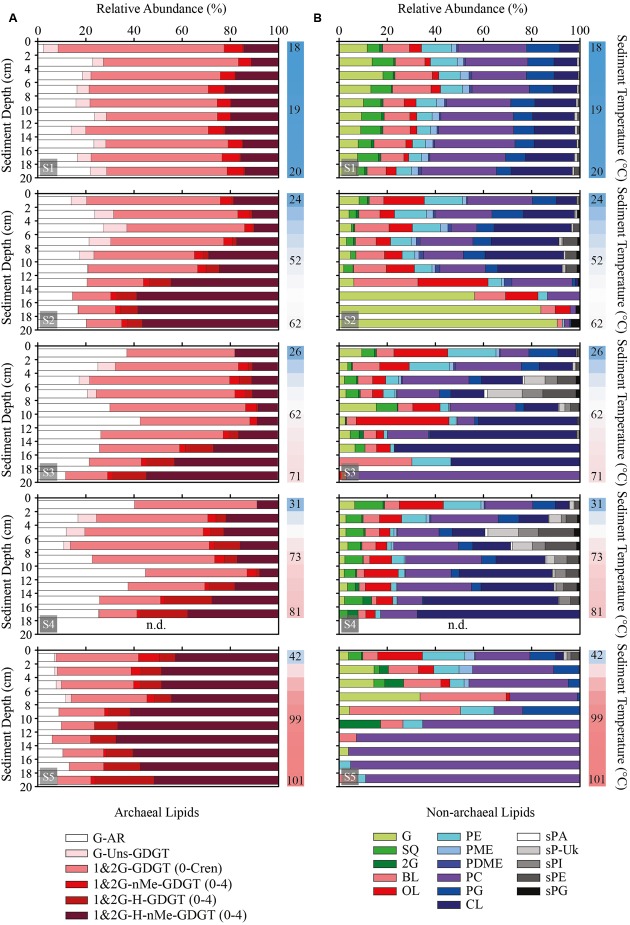
Sediment profiles displaying the abundance of polar lipid classes relative to total archaeal (A) and total non-archaeal (B) lipids. Note that this figure should be interpreted together with the relative abundance of archaeal and bacterial polar lipids shown in Figure 2. Samples were analyzed in 2 cm horizons from surface until 20 cm of sediment depth. Adjacent vertical bars indicate the thermal gradient of each station with upper, mid and bottom sediments temperatures in °C. n.d., no data. Abbreviations: monoglycosidic archaeol (AR); monoglycosidic unsaturated (Uns) acyclic glycerol-dibiphytanyl-glycerol-tetraethers (GDGT); mono- and diglycosidic GDGT with 0 to 5 rings (0-Cren); mono- and di-glycosidic GDGT with up to 4 rings divided into mono- and di-methylated (nMe), H-shaped (H) and H-nMe-GDGT with up to 4 methyl groups. Cren, crenarchaeol. For abbreviations of non-archaeal lipid classes please see Main Text. sP-Uk, unknown glycosylated phosphatidyl sphingolipids.